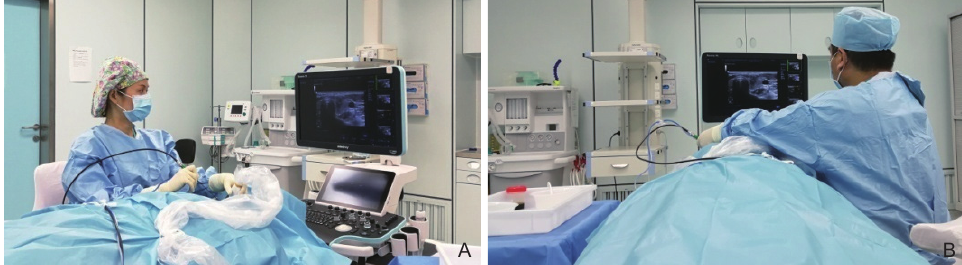
Figure 4 Patient position and puncture operator position: Head-side orientation. (A) The operator stands on the right side of the patient; (B) The operator stands on the left side of the patient.